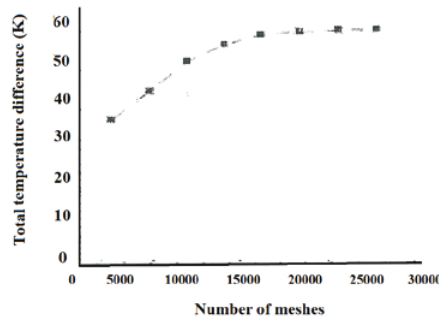
Figure 4. The mesh cells of the (a) axisymmetric and (b) three- dimensional model of the vortex tube